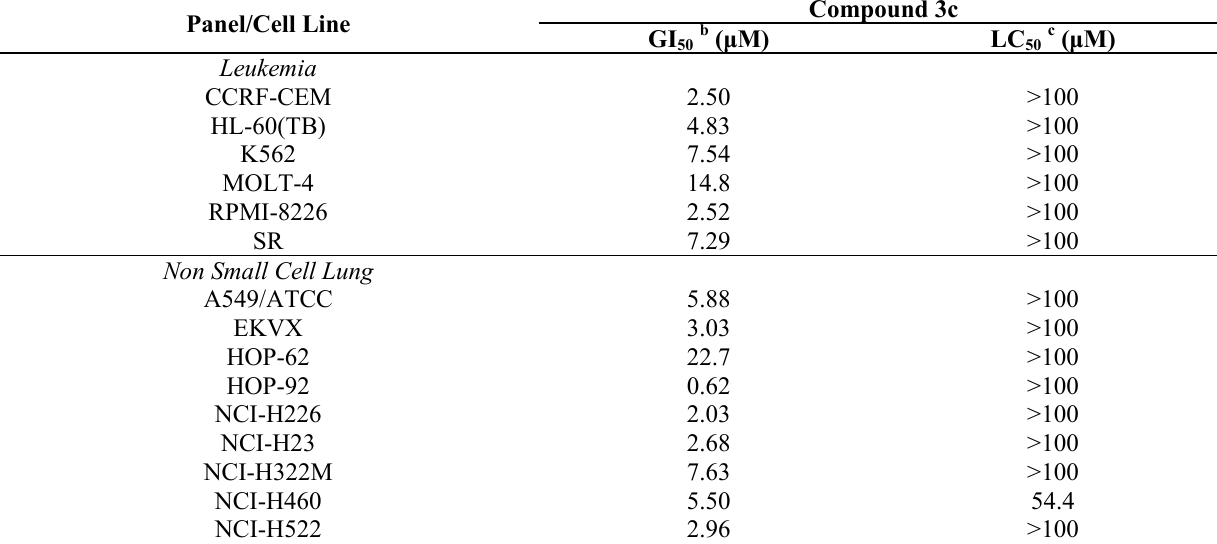
Table 4. In vitro testing expressed as growth inhibition of cancer cell lines for compound 3c a